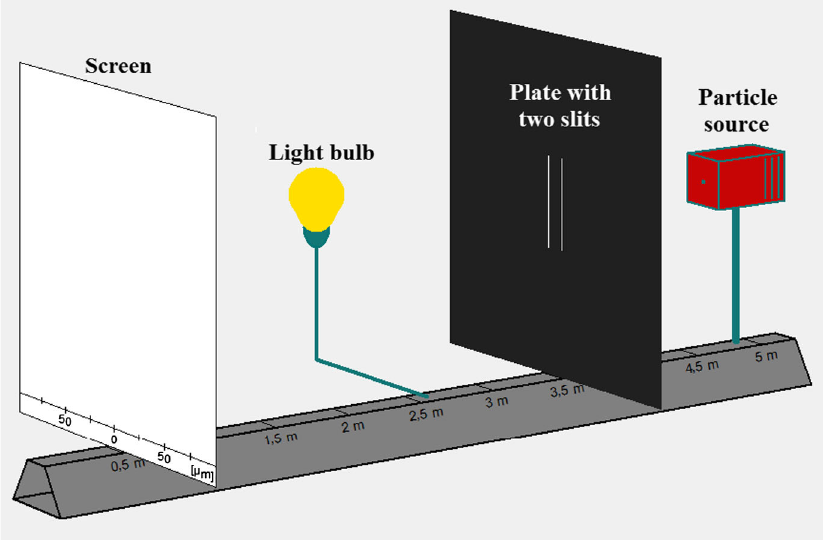
FIG. 7. Double slit setup with the addition of a lamp (image reproduced with permission from a simulation developed by Klaus Muthsam,